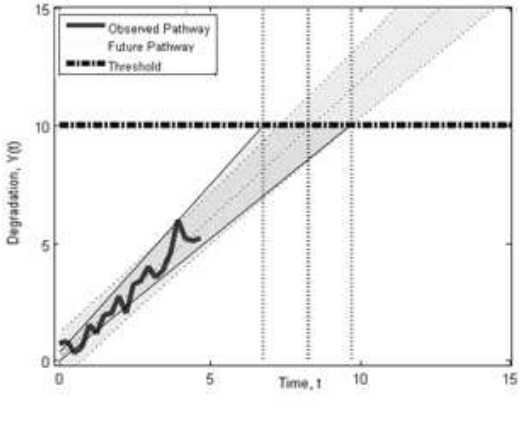
Fig. 6. Linear Path Model